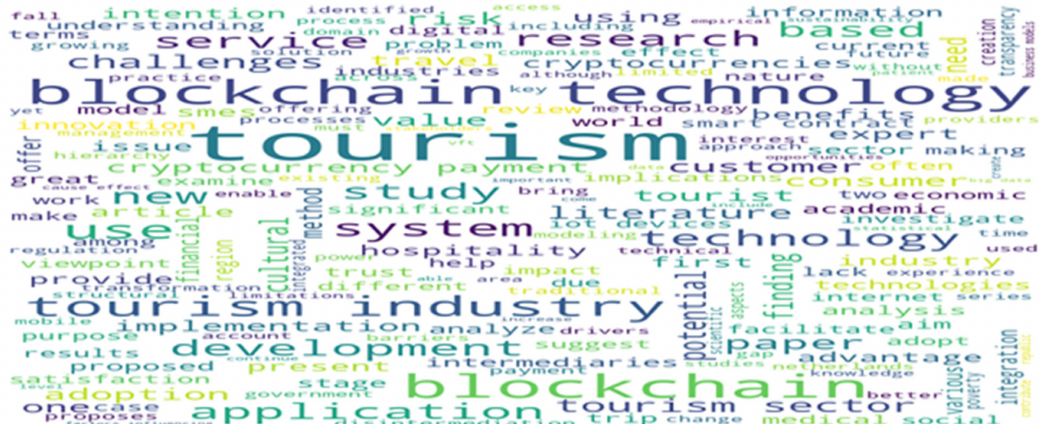
Figure 4. Word cloud for abstract. Source: Authors’ analysis.